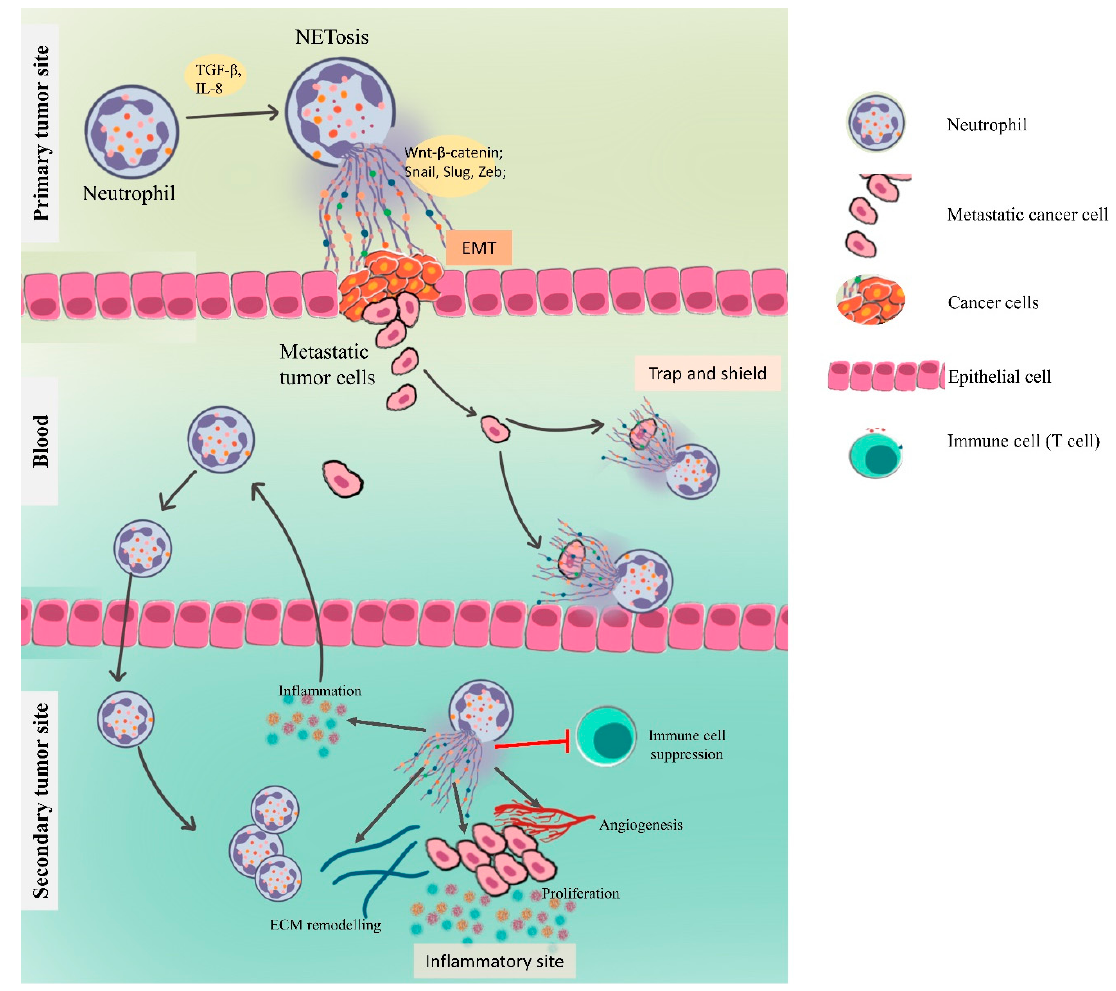
Figure 4. Neutrophil extracellular traps (NETs) induce cancer metastasis: At the primary cancer site, NETs can awaken the dormant cancer cells and can promote epithelial–mesenchymal transition (EMT). Once in the circulation, these circulating cancer cells (CTCs) can become entrapped in the circulating NETs and be protected from immune cells; at the same time, they are exposed to high concentrations of local neutrophil elastase with other factors that can aid in proliferation. The NETs can prepare the secondary/metastatic tumor site, i.e., inhibit immune-surveillance by T cells and NK cells, release MMP-9 and serine proteases which promote angiogenesis via VEGF, modulate extracellular matrix (ECM) in favor of cancer proliferation and recruit inflammatory cytokines which further attract more neutrophils.